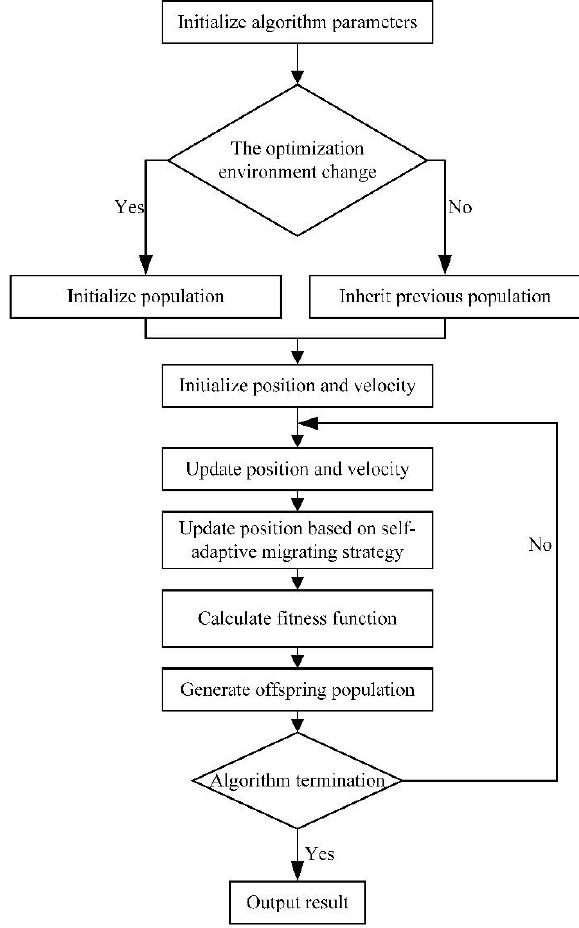
Figure 7. The flow chart of SDMPSO.